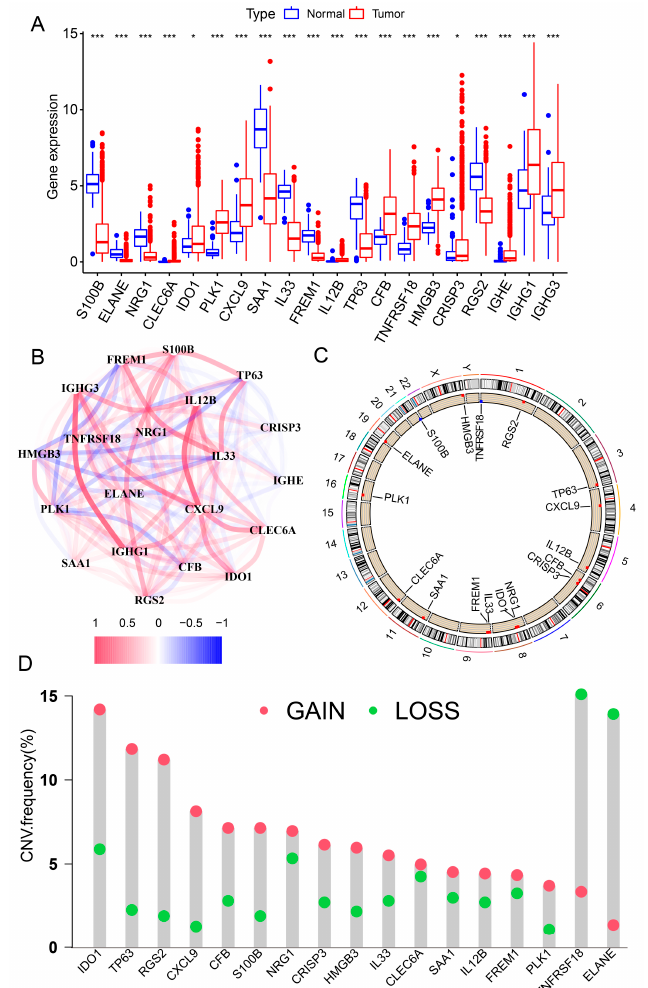
Figure 1. Identification of differentially expressed innate immune-related signatures in breast cancer patients. ( A ) The expression level of these innate immune related signatures in breast cancer were exhibited via the boxplot. * p < 0.05, *** p < 0.001, NS for not significant ( t -test). ( B ) Based-on the transcriptome profiles in breast cancer, the network of the correlation of these innate immune-related signatures were analyzed through correlation analysis. The CNV frequency of immune related signatures were shown in ( C , D